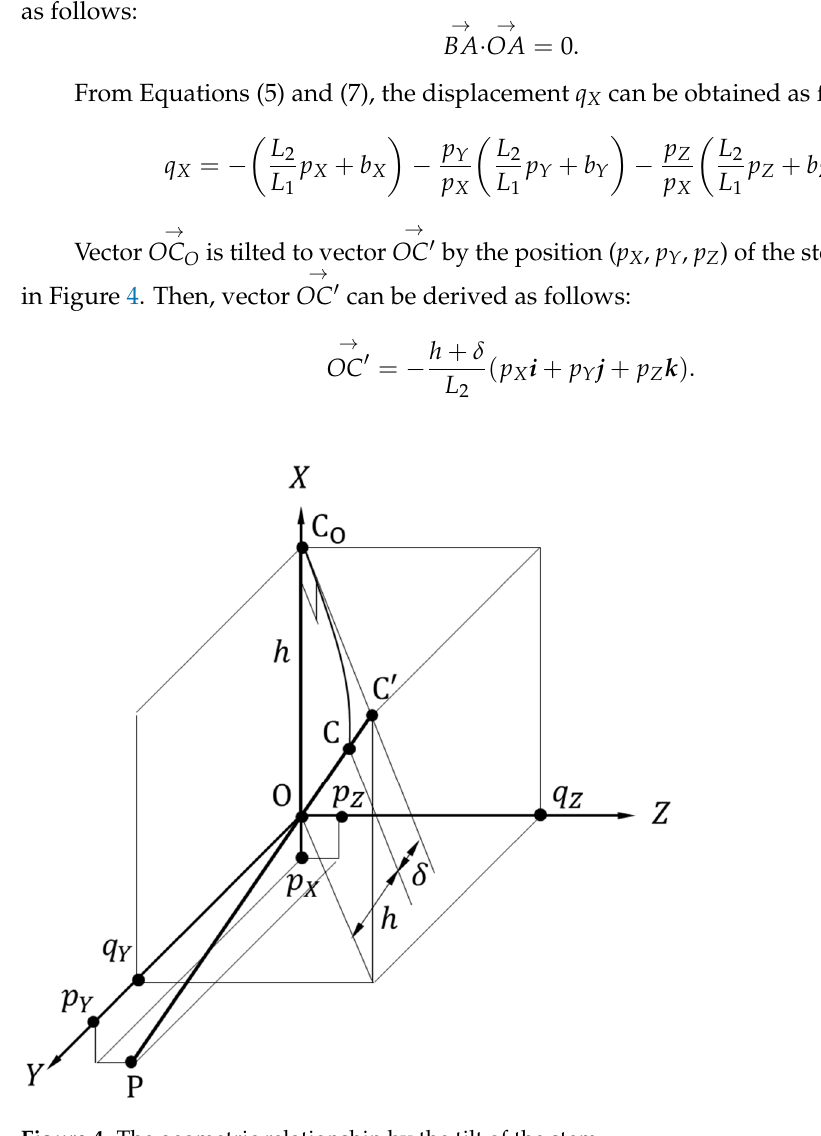
Figure 4. The geometric relationship by the tilt of the stem.